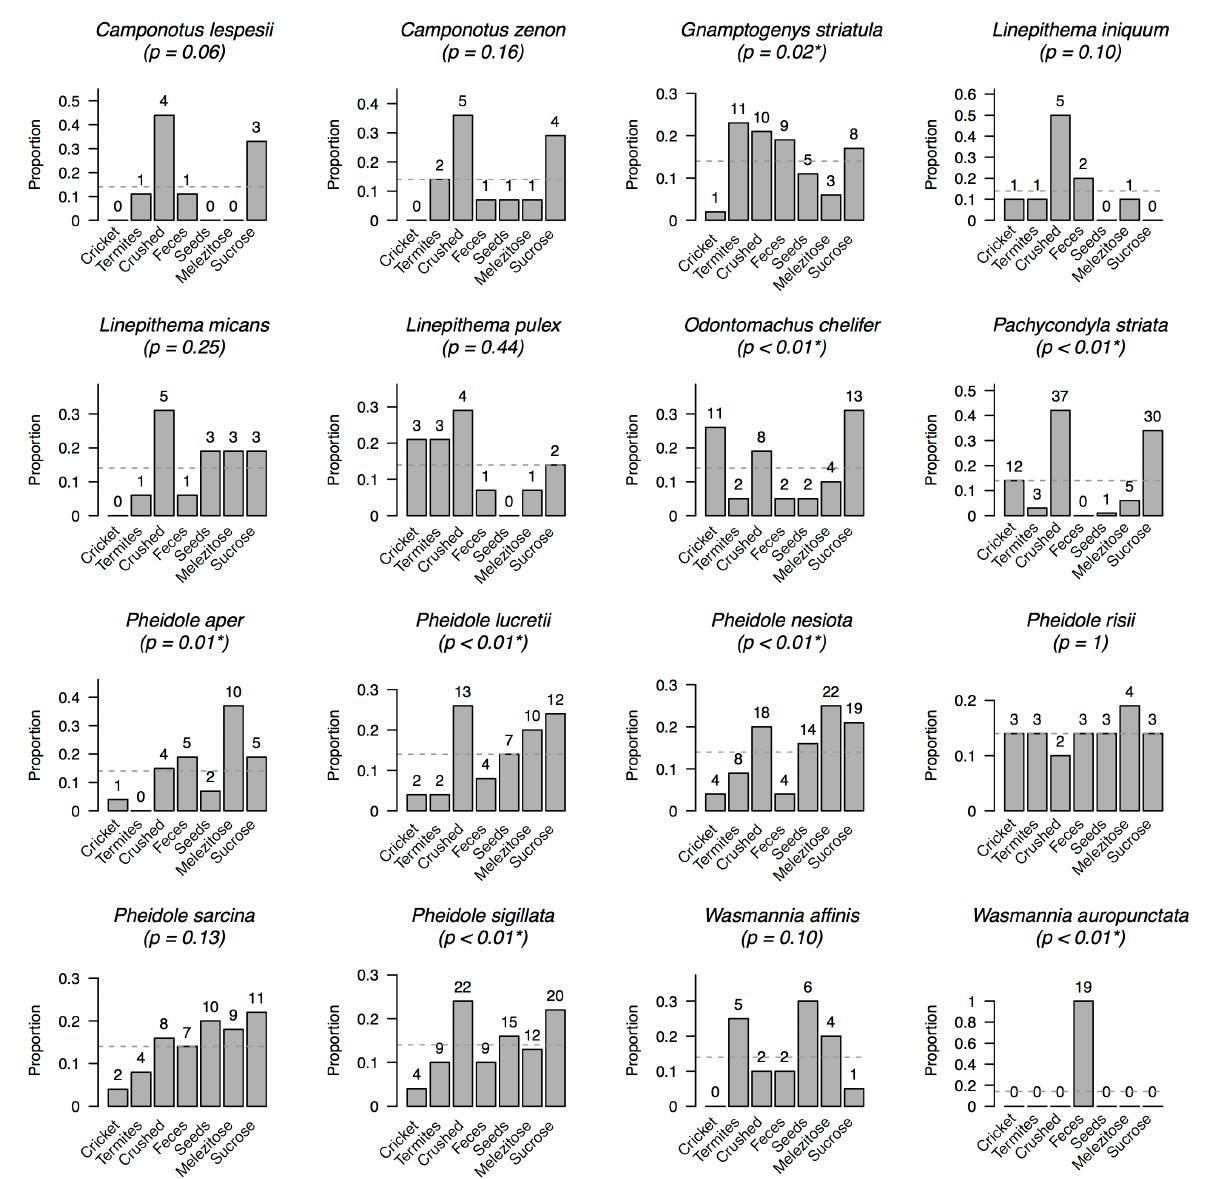
Fig 1 – Use of trophic resources by ant species in southern Brazil. Values above bars are numbers of records. The expected proportions in case of no preference for baits (= 0.14). Asterisks indicate statistical significant